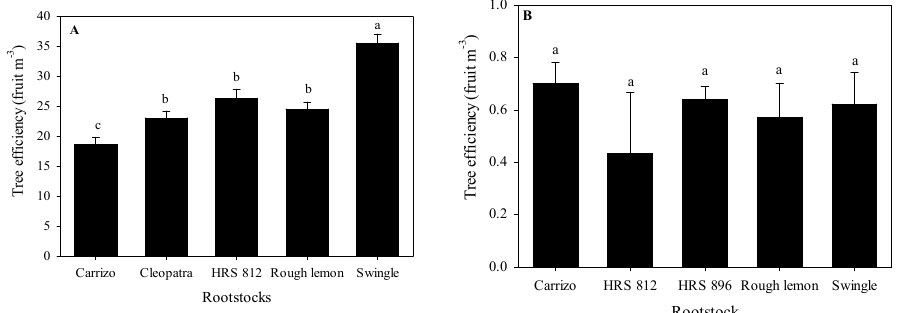
Figure 1. Tree efficiency (fruits m − 3 ) of ( A ) Tahiti lime and ( B ) Nova mandarin grafted to five different rootstocks planted at the Agricultural Experiment Substation of Isabela, Puerto Rico from April 2015–May 2016. Vertical lines represent the standard errors and lower case letters are different if there were statistical differences among the rootstocks by Tukey’s test ( p < 0.10) for each citrus species.